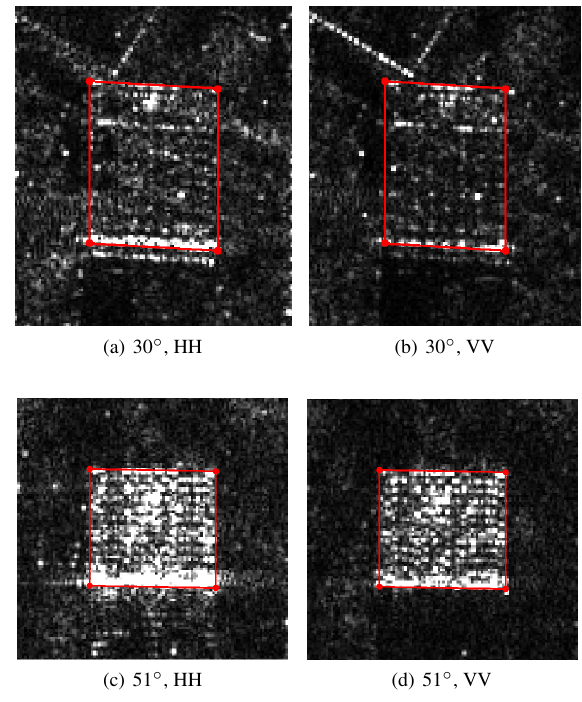
Figure 1. Facade at Hansaviertel, Berlin. Extracted facade lay- over areas indicated by red frames. HH: signal emitted and de- tected in horizontal plane. VV: signal emitted and detected in vertical plane. Time difference between HH and VV data takes: 11 days.